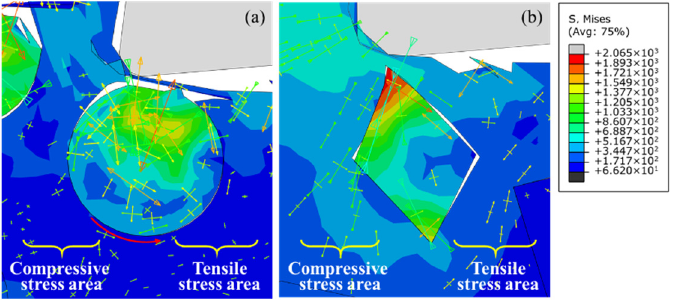
Figure 8. Stress distribution of single particles below the cutting path with different particle shapes: